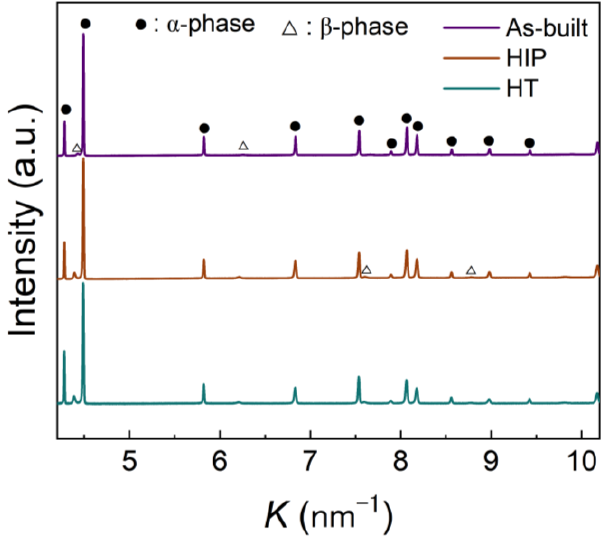
Figure 3. TOF-ND profiles for the as-built, HIP, and HT specimens, as obtained at the BS bank of the iMATERIA beamline at J-PARC.